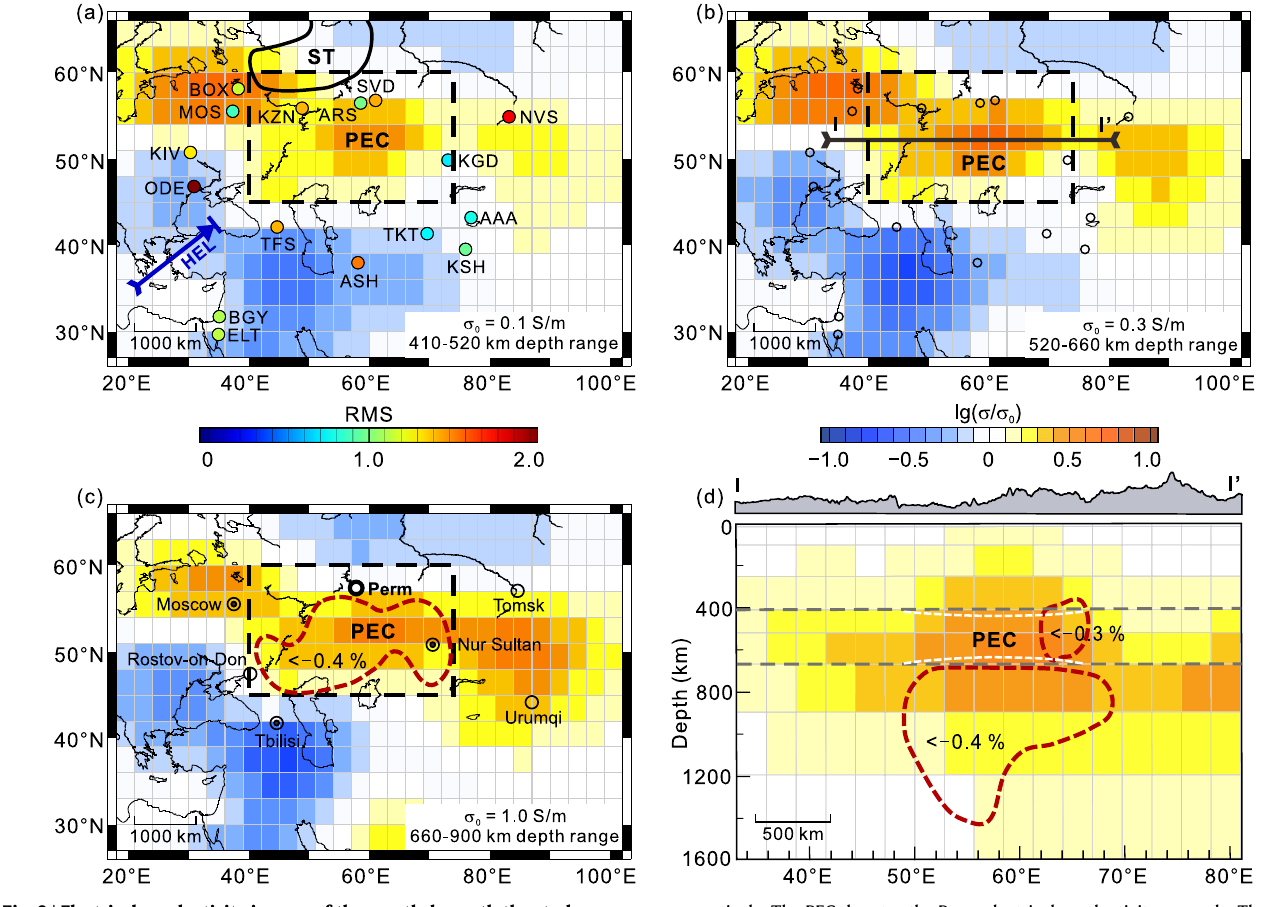
respectively. The PEC denotes the Perm electrical conductivity anomaly. The blue linewithanarrowindicatesthesubductiondirectionandfrontoftheHellenic(HEL) slab 39,66 .TheblacklinelabelledI – I ’ in( b )marksthelocationoftheverticalsectionin ( d ). σ 0 is the global average conductivity. d Electrical structure beneath the I – I ’ pro fi lealong51°Nin( b ).Dashedwhitelines,whichareverticallyexaggerated,show the depressed 410-km and elevated 660-km discontinuities 43 . Dashed red lines in ( c , d ) denote low-velocity bodies 40